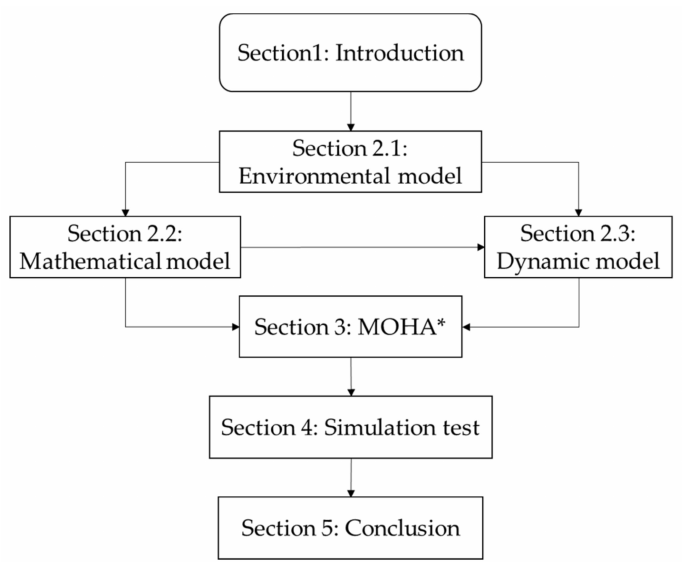
Figure 1. Section structure diagram of this paper.